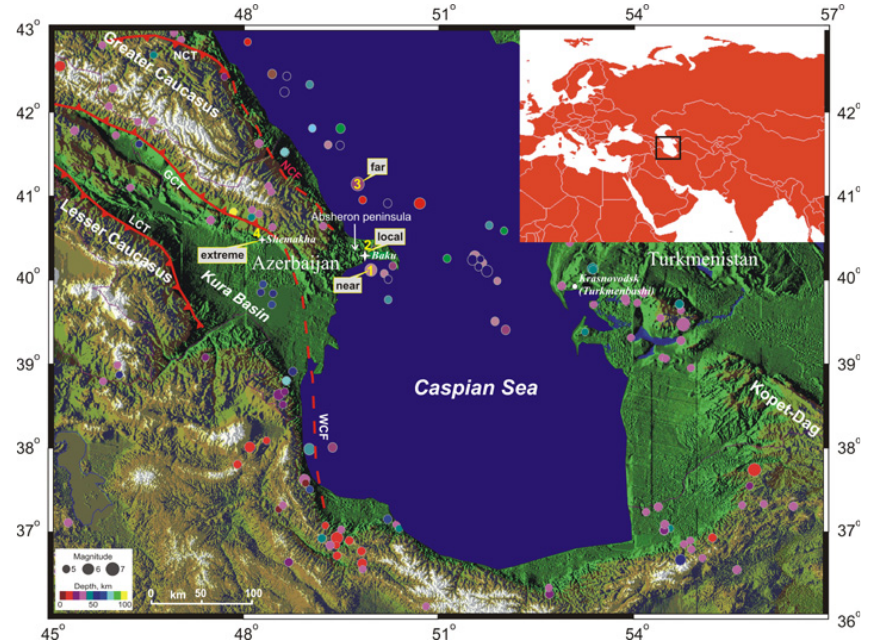
Fig. 1. Topography, simplified tectonics, and seismicity of the Caucasus to the Kopet-Dag region. The inset presents a map of central Eurasia showing the region’s location. Earthquake epicentres are marked by circles, and the colours of the circles provide information on the depth of the earthquake hypocenters (earthquakes of magnitude 5 and greater for the period of 1950–2006 are plotted here). Target earthquakes are marked by numbers: (1) , the 2000 M = 6 . 3 Caspian earthquake; (2) , the 1935 M = 3 . 5 Surakhani earthquake; (3) , the 1963 M = 6 . 5 Caspian earthquake; and (4) , the hypothetical extreme event in Shemakha. Abbreviations: NCT, North Caucasus thrust fault; GCT, Greater Caucasus thrust fault; LCT, Lesser Caucasus thrust fault; WCF, West Caspian fault; and NCF, North Caspian